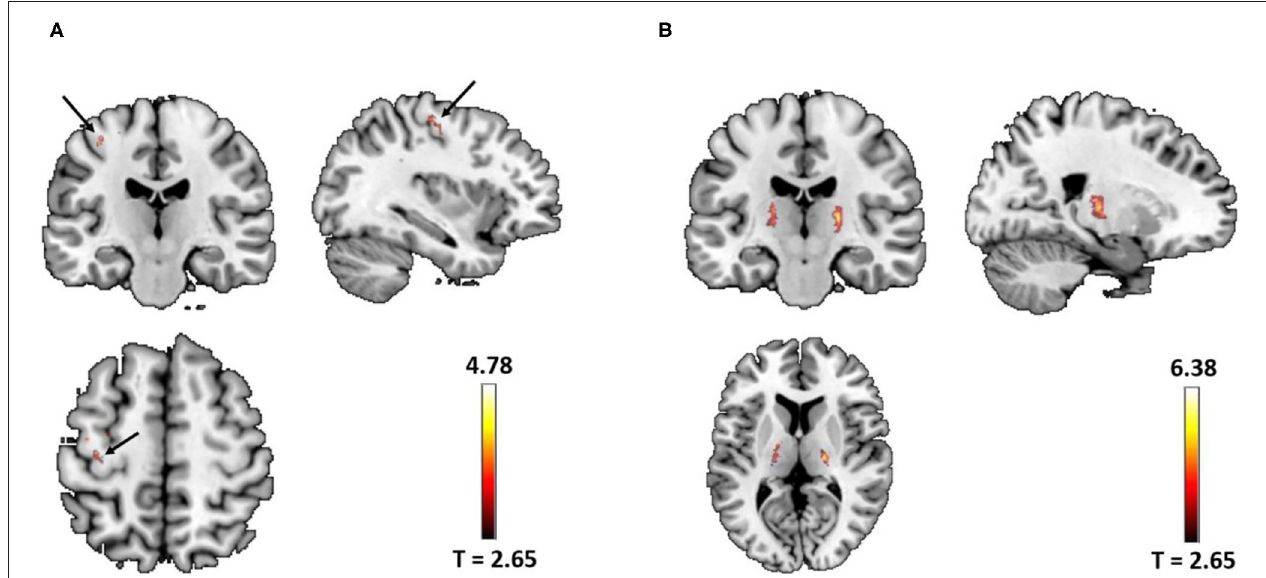
FIGURE 1 | (A) Significant increased quantitative susceptibility mapping (QSM) values were found in the left precentral gyrus (arrow) in patients with amyotrophic lateral sclerosis (ALS) (peak voxel P SVC = 0.03). (B) Significant increased QSM values were found in the bilateral thalamus in patients with ALS (left P SVC = 0.02; right P SVC < 0.001). Images were shown with a P < 0.005 uncorrected thresholds and masked with the left precentral and the thalamus from the AAL atlas. In total, there were 220 voxels and 1,674 voxels surviving P uncorrected < 0.005 thresholds in the left precentral gyrus and the bilateral thalamus,